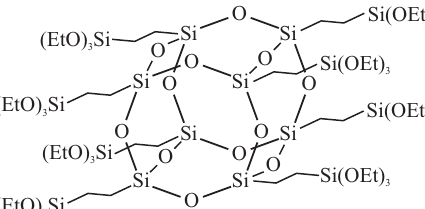
Figure 7. The cage-like structure of octa(triethoxysilylethyl)polyhedral oligomeric silsesquioxane. Et, ethyl